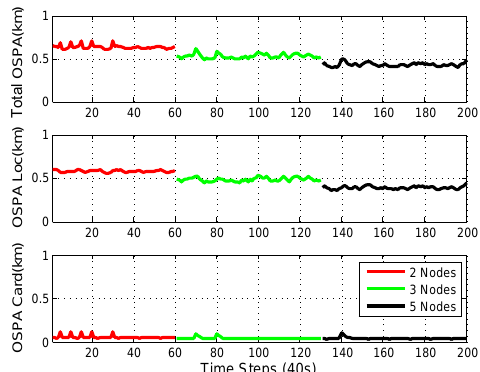
Figure 13. OSPA performance for time-varying